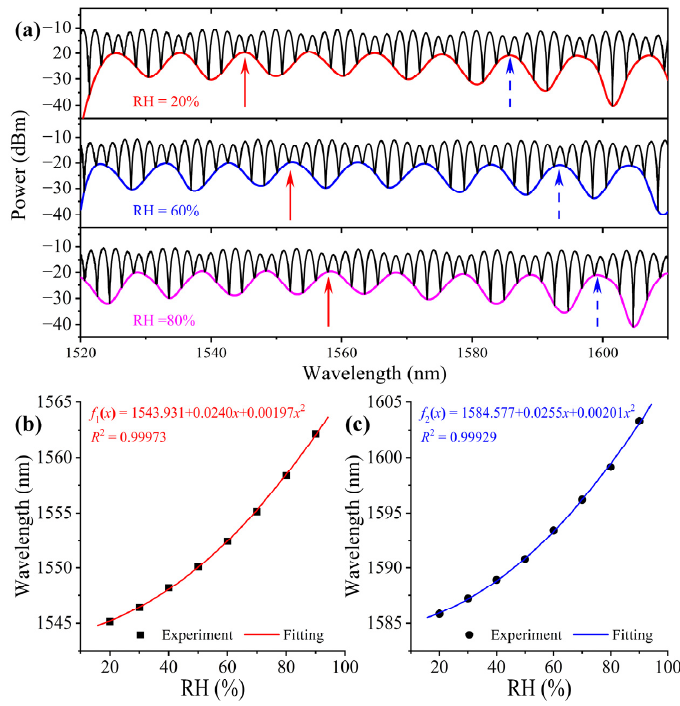
Figure 5. ( a ) Reflection spectra at different RH and the two peaks at the initial position of 1545.1nm and 1585.8nm at 30 °C pointed by red and blue arrows. ( b , c ) wavelength as function of RH of the two peaks.